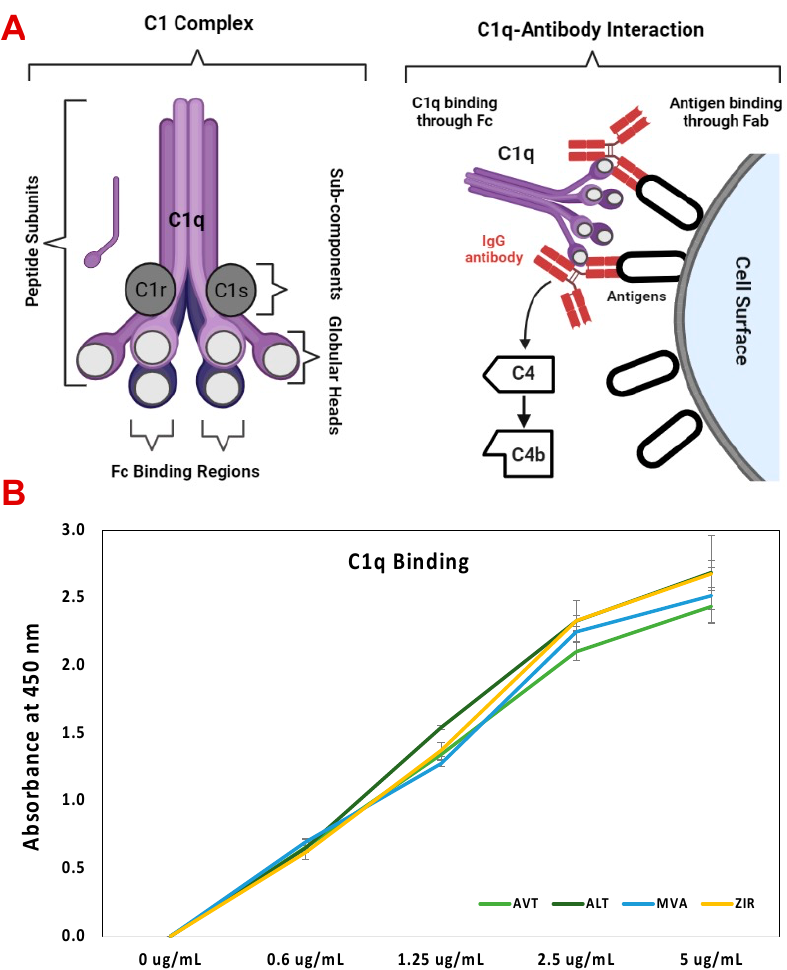
Figure 8. C1q binding analysis of the samples. ( A ) Schematic illustration of C1q complex (left) and basic C1q and IgG interaction (right). ( B ) The results of C1q binding of AVT, ALT, ZIR, and MVA by ELISA at different concentrations. The data represented the mean of at least three independent measurements. There was no significant difference between Avastin, and other samples based on the statistical analysis ( p < 0.05).